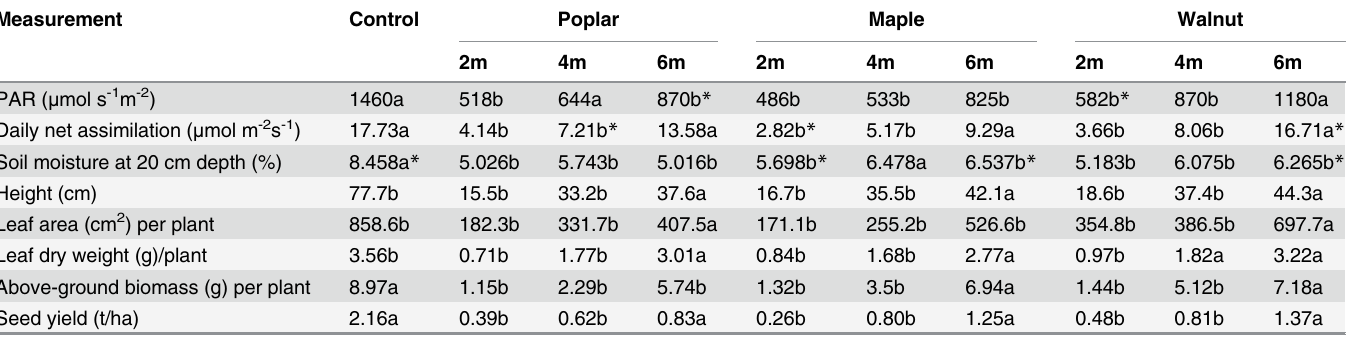
Table 3. Within plot microclimate and soybean responses 2, 4, and 6 m from tree row to three 26-year-old hardwood intercropping systems and monocropped soybeans. Measurement